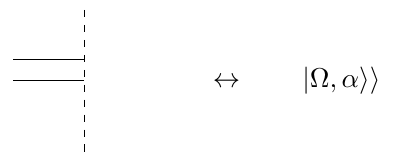
Figure 4 . Graphical representation of the boundary state in the ( p; q )-web